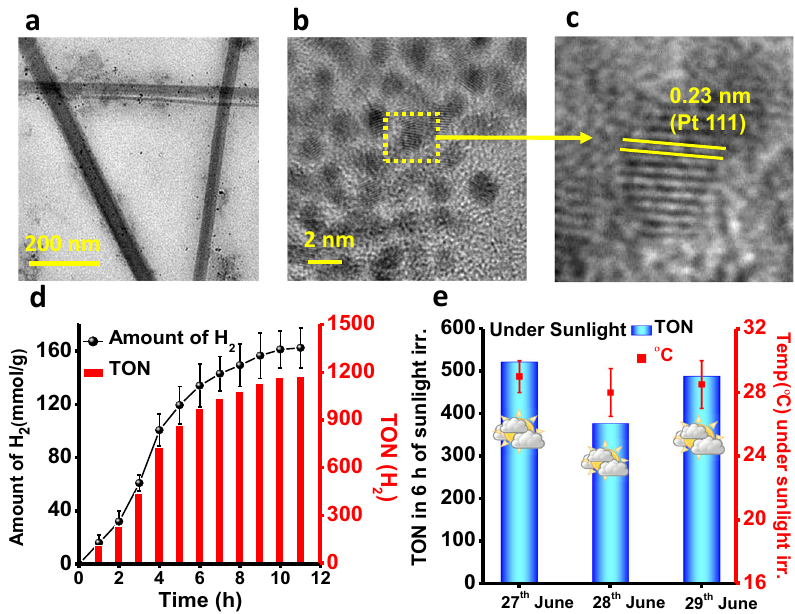
Fig. 6 Characterizations and photocatalytic H 2 production activity of Pt@Zn-TPY-TTF CPG. a , b HR-TEM images of Pt@Zn-TPY-TTF CPG. c Lattice fringes of the selected region. d Amount and TON (for H 2 ) under visible-light irradiation and error bars represents the standard deviations of three catalytic runs. e TON (for H 2 ) under direct sunlight irradiation from 27th June to 29th June 2019 (10:00 am to 4:00 pm) and the error bars represents the temperature range of photocatalytic set-up during catalysis under the sunlight